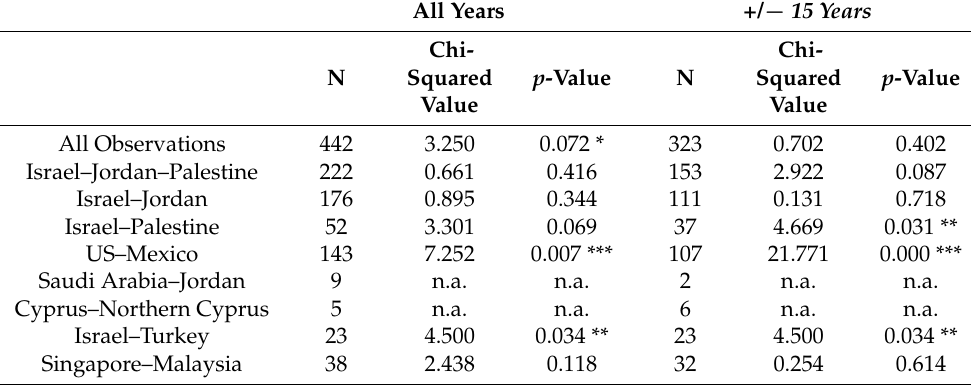
Table 3. Summary of chi-squared test results.